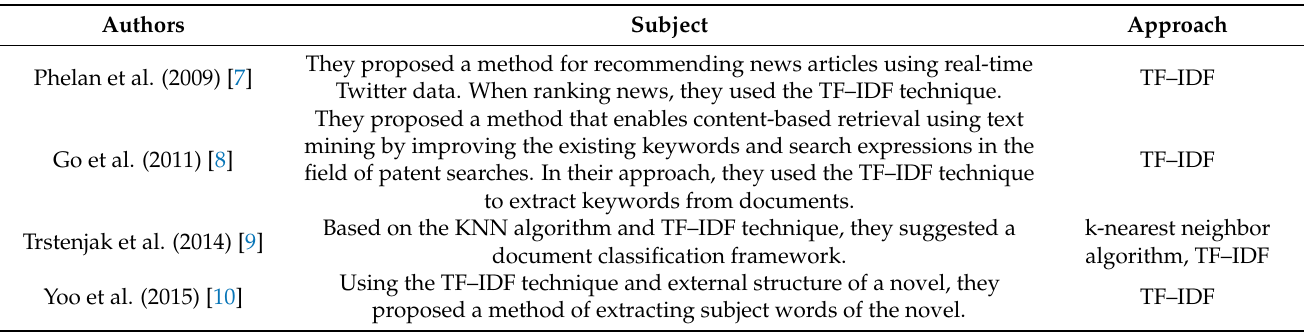
Table 2. Previous works on